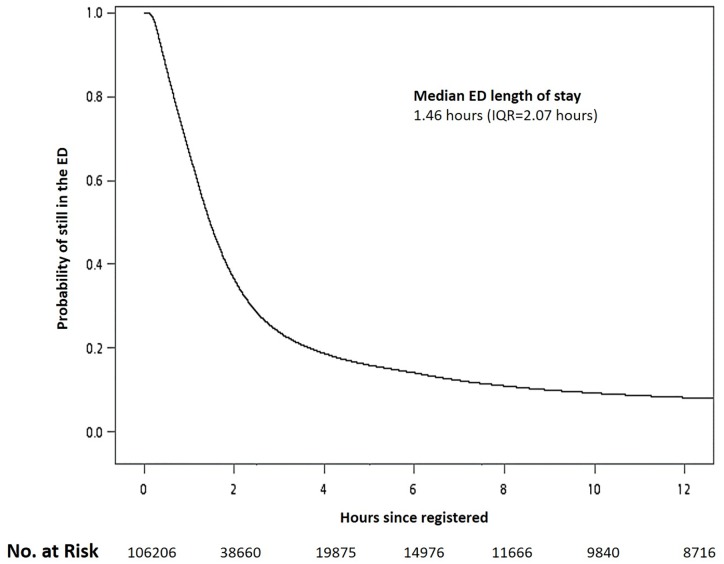
Kaplain-Meier plot for ED length of stay in discharged patients.